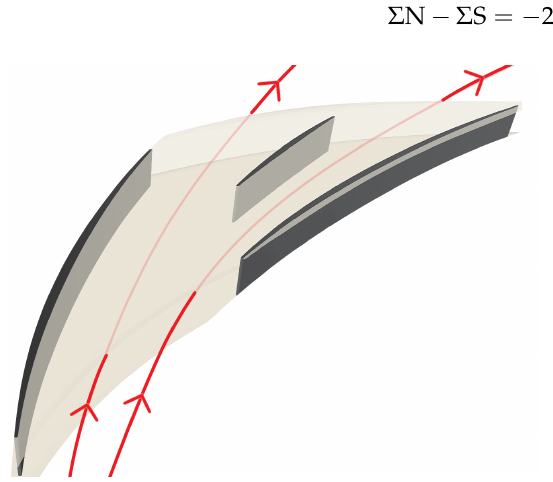
Figure 7. Three-dimensional representation of the analysis subdomain. The shroud surface is set with low opacity. Red arrows represent the flow